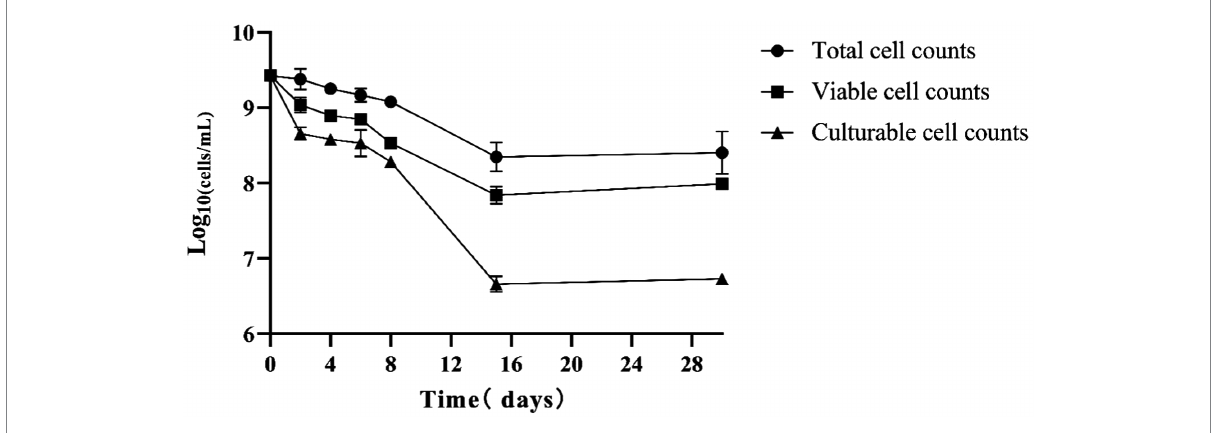
FIGURE 7 Induction of VBNC state of Rhodococcus sp. (GX12401).